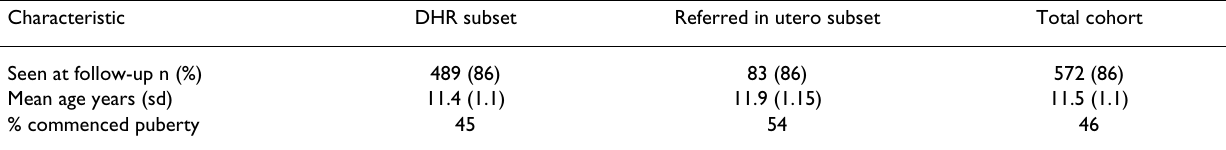
Table 5: Cross-sectional characteristics at follow-up. Aboriginal Birth Cohort Study 1998–2001 Characteristic DHR subset Referred in utero subset Total cohort Seen at follow-up n